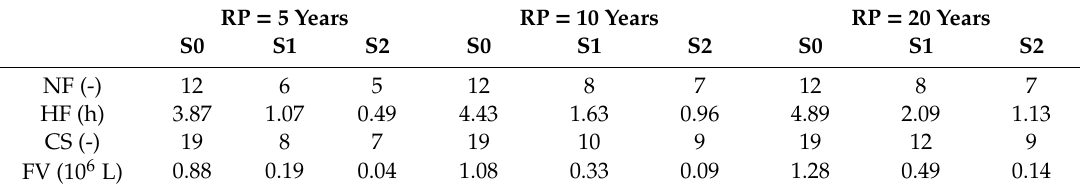
Table 3. Node Flooding (NF), Hours Flooded (HF), Conduit Surcharge (CS), and total Flood Volume (FV) for each scenario (S0, S1, S2) and each design rainfall event of 5, 10, and 20-year return periods (RP).